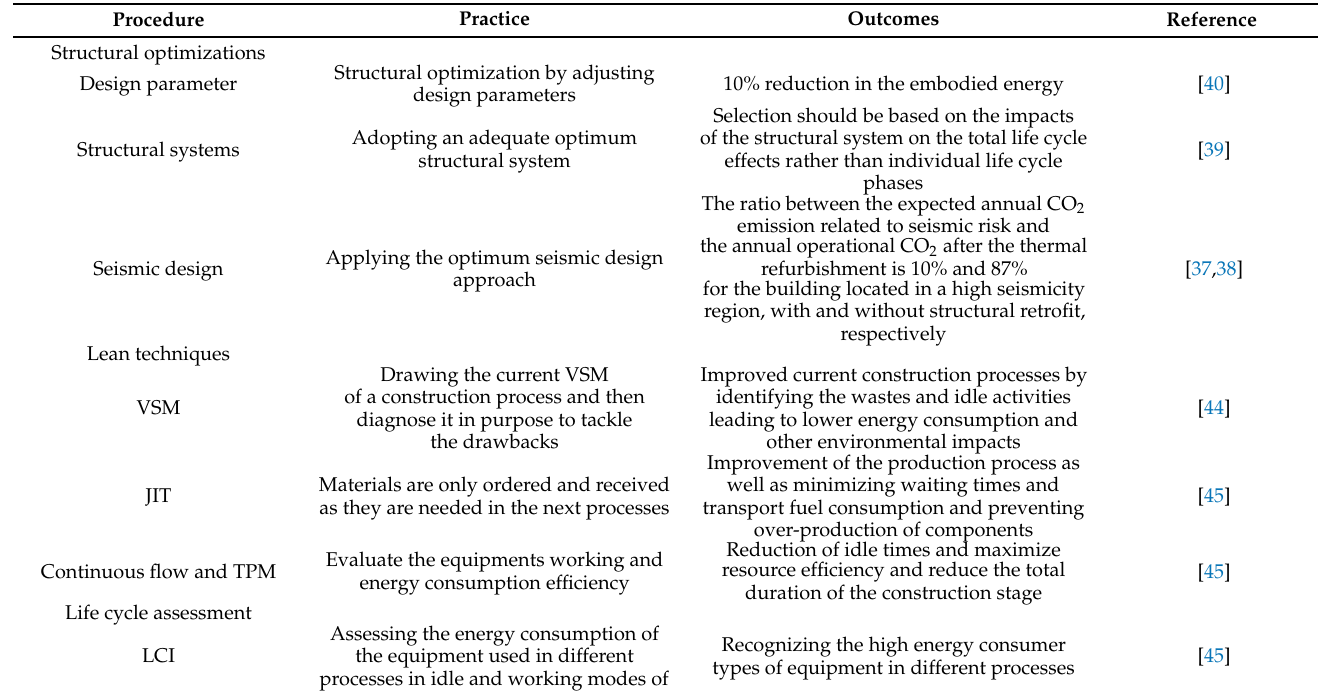
Table 10. The procedure and the expected outcome of the proposed algorithm aiming to reduce the energy consumption and carbon emissions in the processes of the construction of a